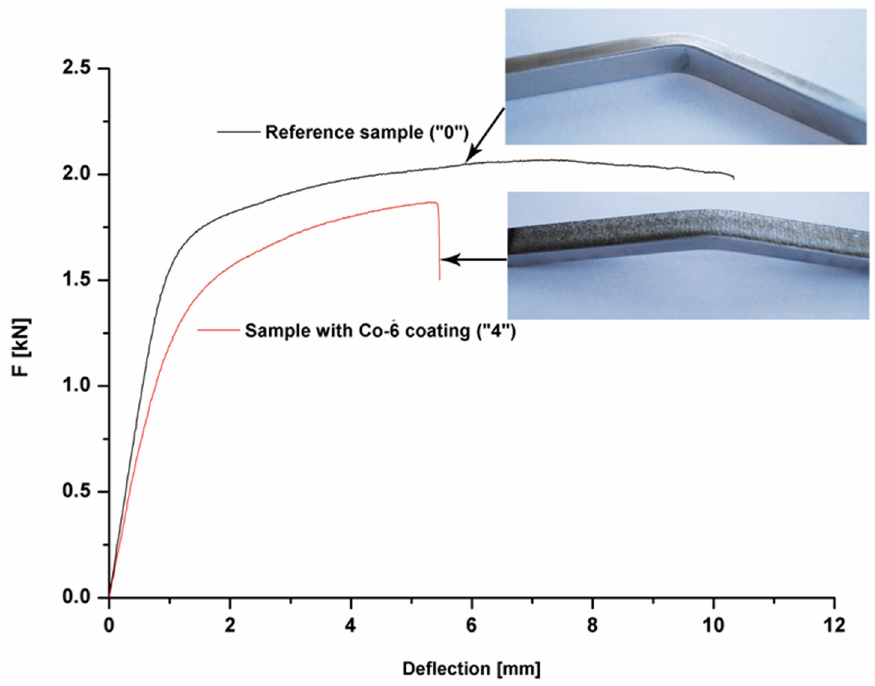
Figure 9. The force vs. deflection curves for the Co-6 coating #4 and without the Co-6 coating #0.